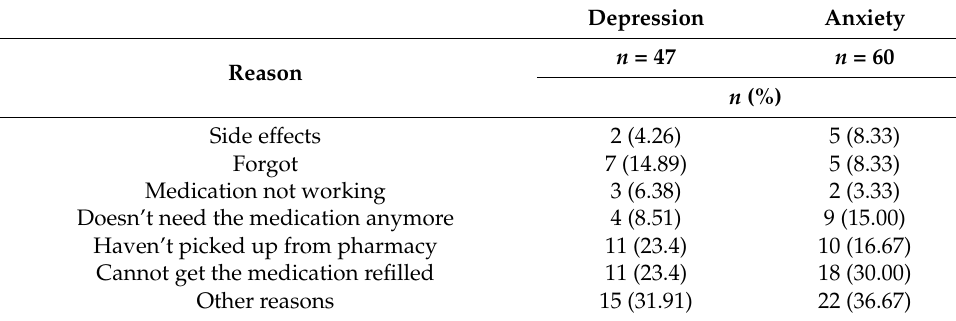
Table 5. Frequency of Reasons for Psychiatric Medication